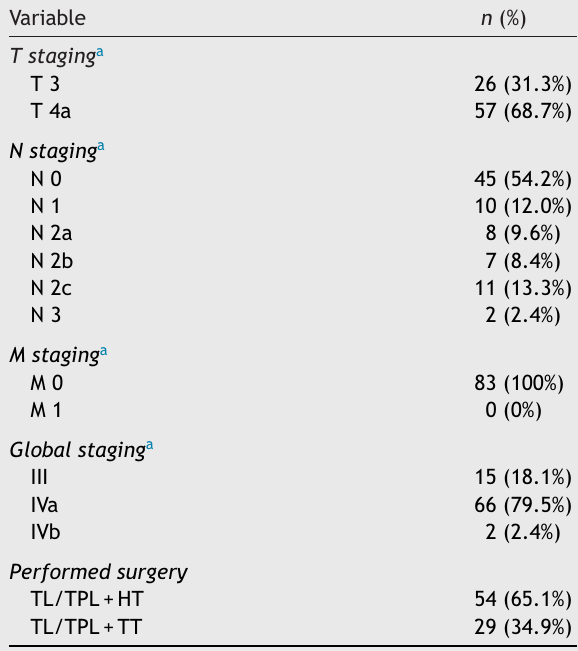
Patients with laryngeal and/or hypopharyngeal SCC submitted to TL or TPL with HT or TT --- clinical